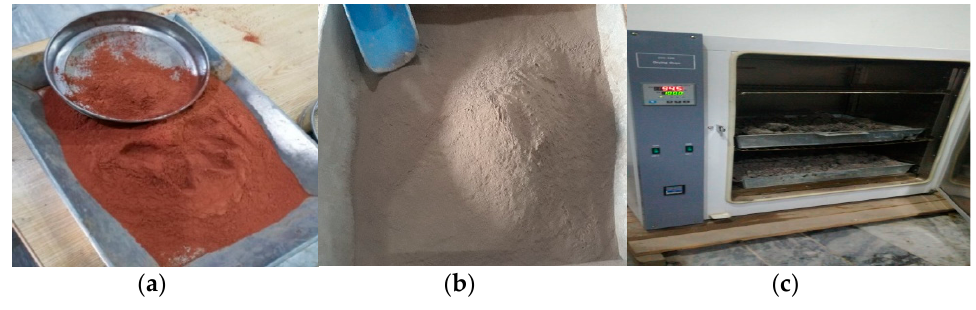
Figure 2. ( a ) Brick Dust ( b ) Powdered Alum ( c ) Oven for Drying.